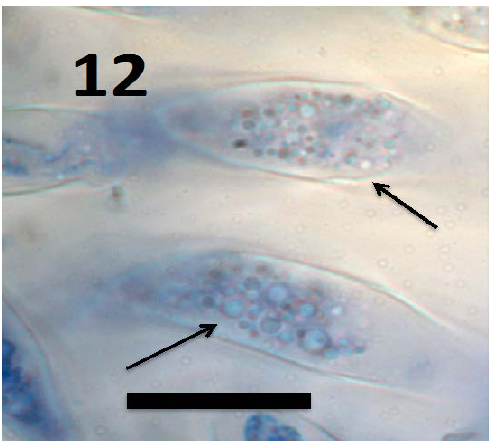
Figure 12. L-forms of Bacillus amyloliquefaciens (arrows) in root cap cells of grass Urochloa ramosa (bar = 15 µm; stained with 3,3-diaminobenzidine followed by aniline blue).